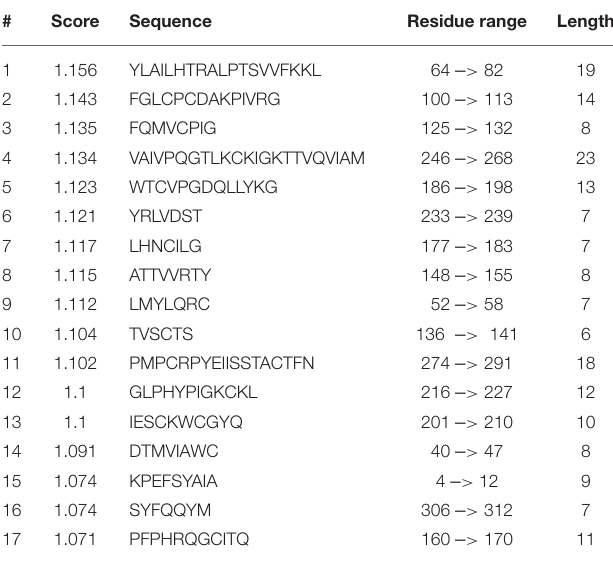
The antigenic sites were sorted by descending score of the EMBOSS antigenic tool.